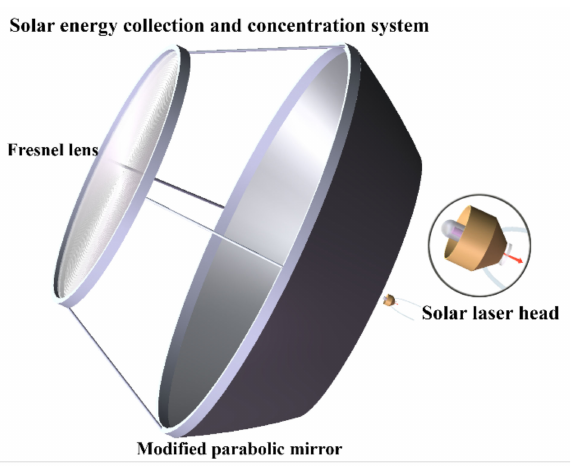
Figure 1. Model of the solar-pumped laser consisting of the solar energy collection and concentration system and the solar laser